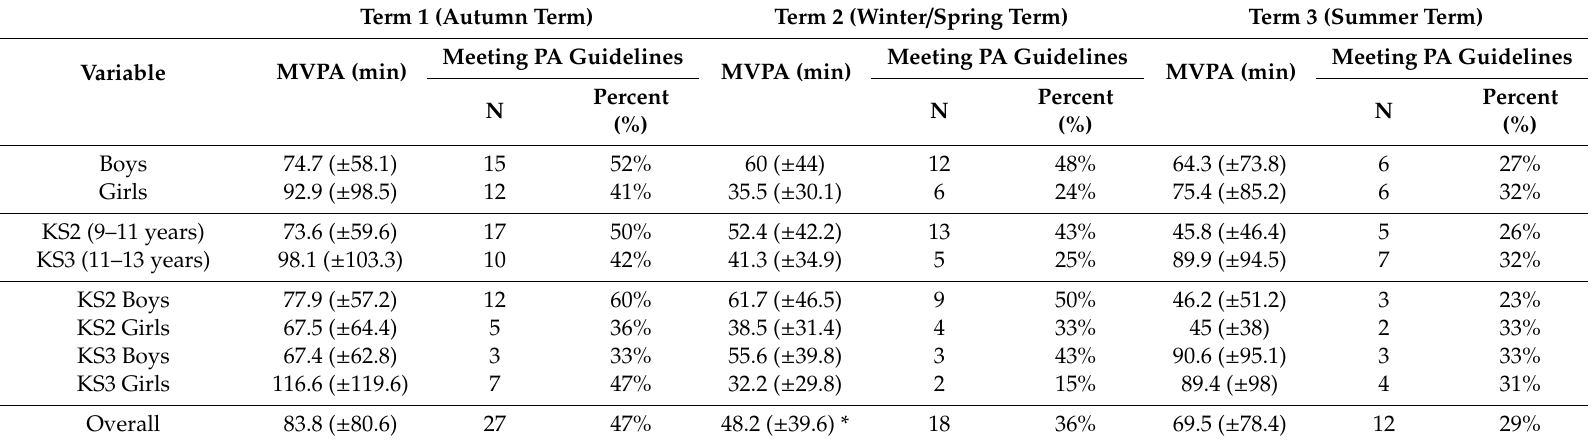
Table 2. Mean daily moderate–vigorous physical activity (MVPA) time, and the number of children meeting the physical activity (PA) guidelines according to each school